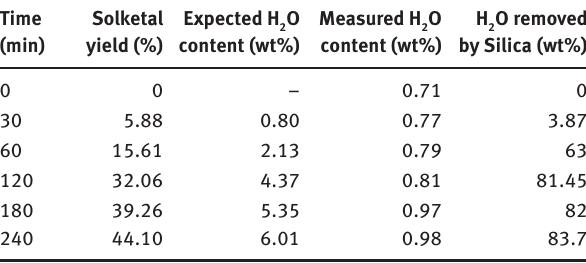
Table 2: Water removal by silica for reactions at 2:1 of acetone to oil molar ratio, 10:1 of methanol to oil molar ratio, 0.5 mole of DBSA/1 mol RSO and 50°C.